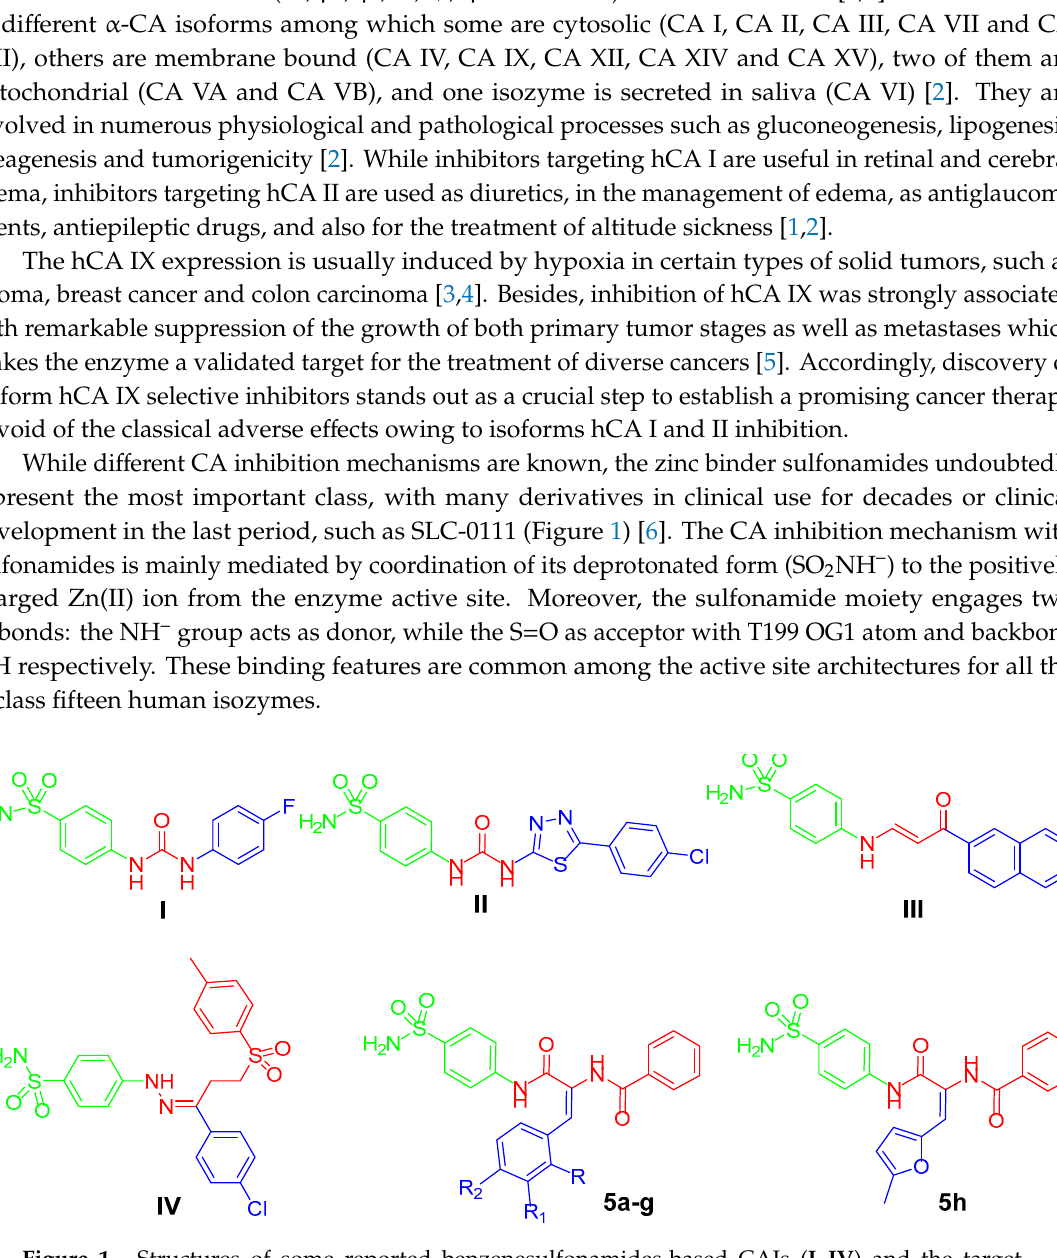
Figure 1. Structures of some reported benzenesulfonamides-based CAIs ( I – IV ) and the target compounds (5 a – g and 5 h ).